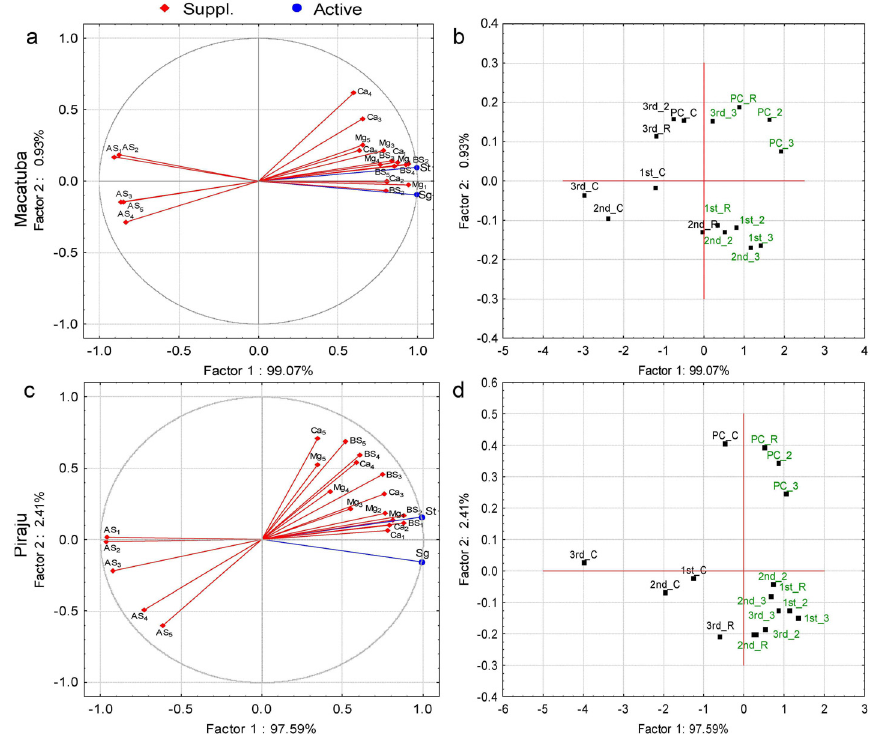
Figure 3. Projection of the dataset subjected to principal component analysis based on the correlations of stalk (St) and sugar (Sg) yields with ( a , c ) soil chemical attributes (Ca, calcium; Mg, magnesium; BS, base saturation; and AS, aluminum saturation) and depths (1, 0.0–0.2 m; 2, 0.2–0.4 m; 3, 0.4–0.6 m; 4, 0.6–0.8 m; and 5, 0.8–1.0 m); and ( b , d ) lime rate (C, control; R, recommended lime rate; 2, 2 × recommended lime rate; 3, 3 × recommended lime rate) at Macatuba and Piraju under modified deep strip-tillage (MDT) for plant cane (PC) and first (1st), second (2nd) and third (3rd)